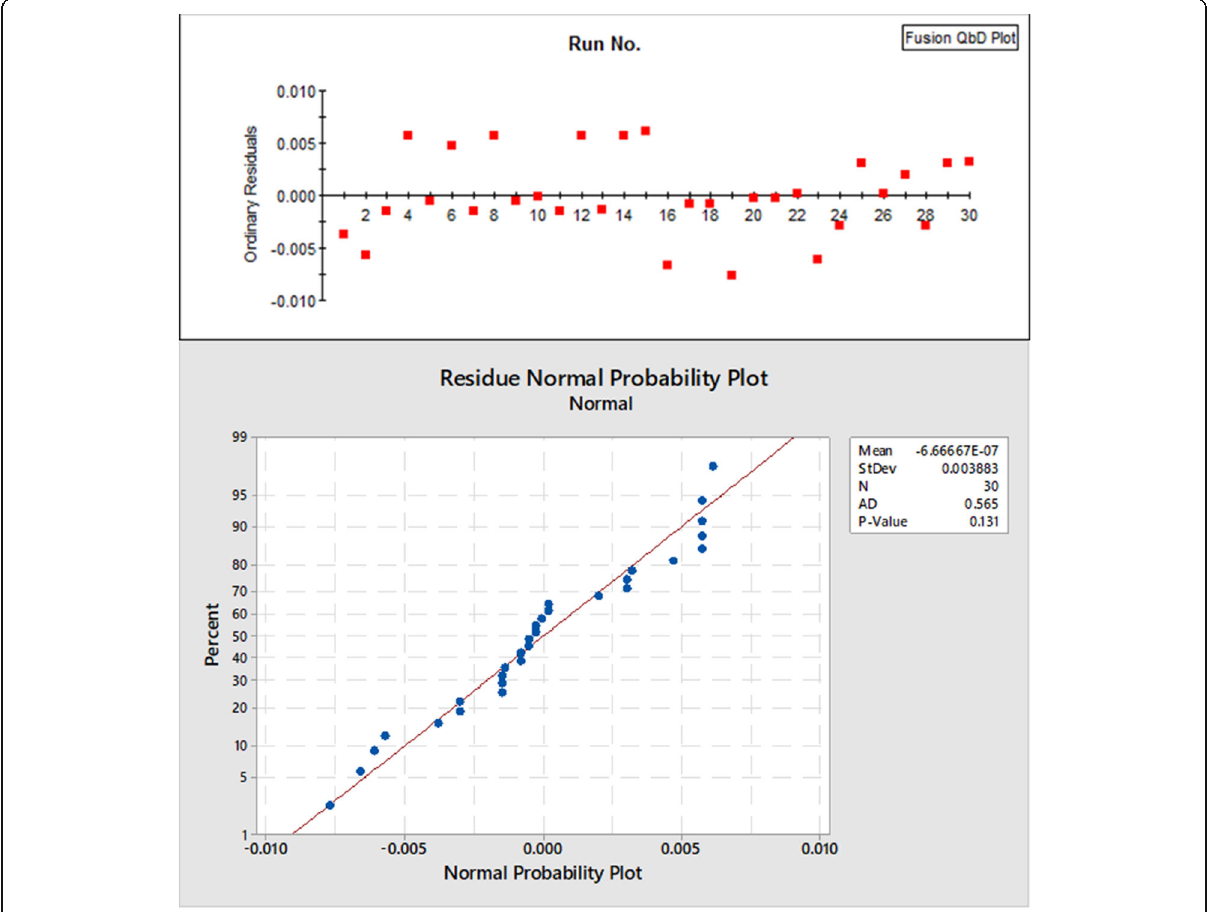
Fig. 3 Representative residuals plot for the “ # of Peaks ” model. Upper: run no – residuals plot; lower: residues normal probability